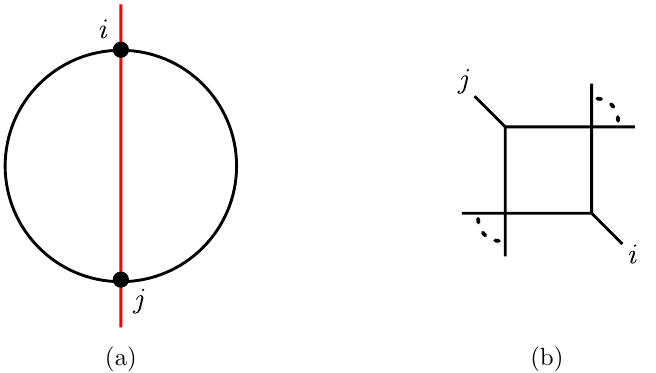
Figure 2. (a) A maximum codimension boundary of the one-loop MHV amplituhedron. The circle is a schematic depiction of the n line segments (1 2), (2 3), . . . , ( n 1) connecting the n cycli- cally ordered external kinematic points Z i 2 G + (4 ; n ) and the red line shows the loop momentum L = ( i j ). (b) The corresponding Landau diagram, which is a graphical depiction of the four cut conditions (3.3) that are satis(cid:12)ed on this